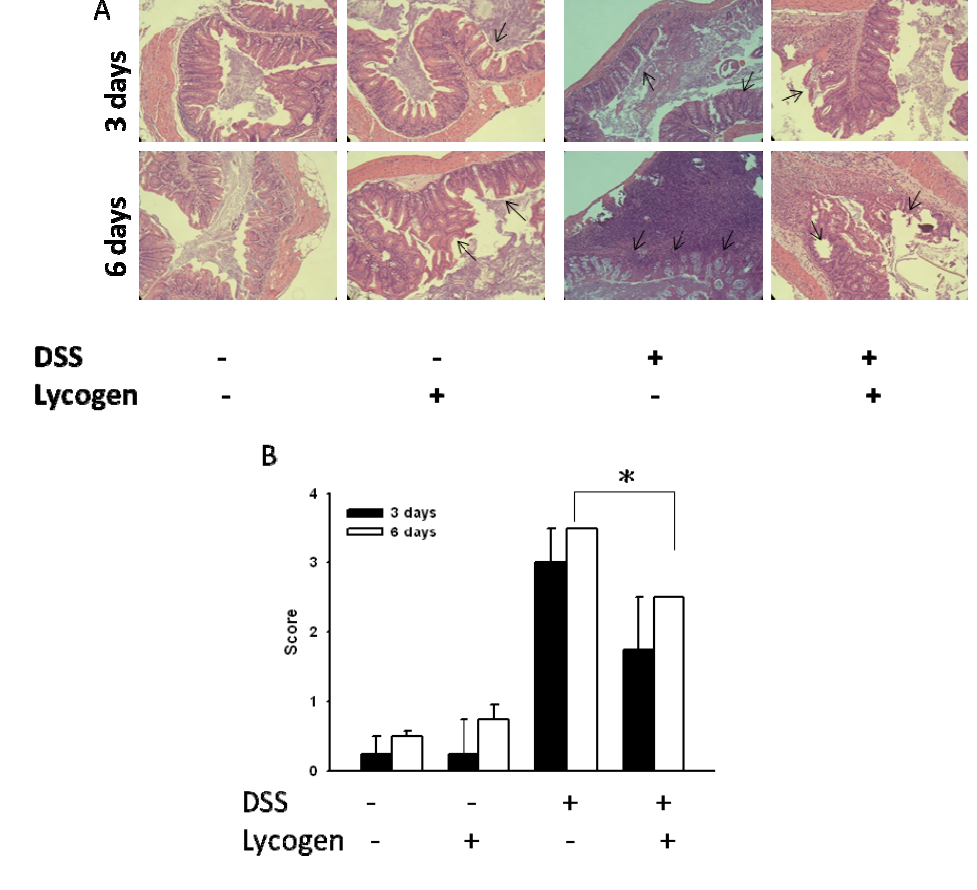
Figure 4. Therapeutic effect of Lycogen™ in mice with DSS-induced colitis. Mice were orally administered Lycogen™ (1 mg/kg) for six consecutive days after DSS induction. ( A ) Microscopic features of the colon at day 3 and day 6. Arrows indicate the damaged sites. ( B )The microscopic score of DSS-induced colitis (means ± SD, n = 4). Significance of differences between groups for continuous variables was assessed using the Student t-test. * p <